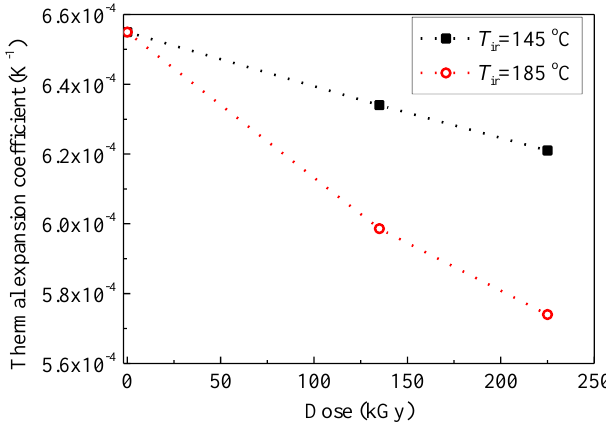
Figure 8. Thermal expansion coe ffi cient β as a function of dose irradiated at temperatures T ir of 145 and 185 °C.